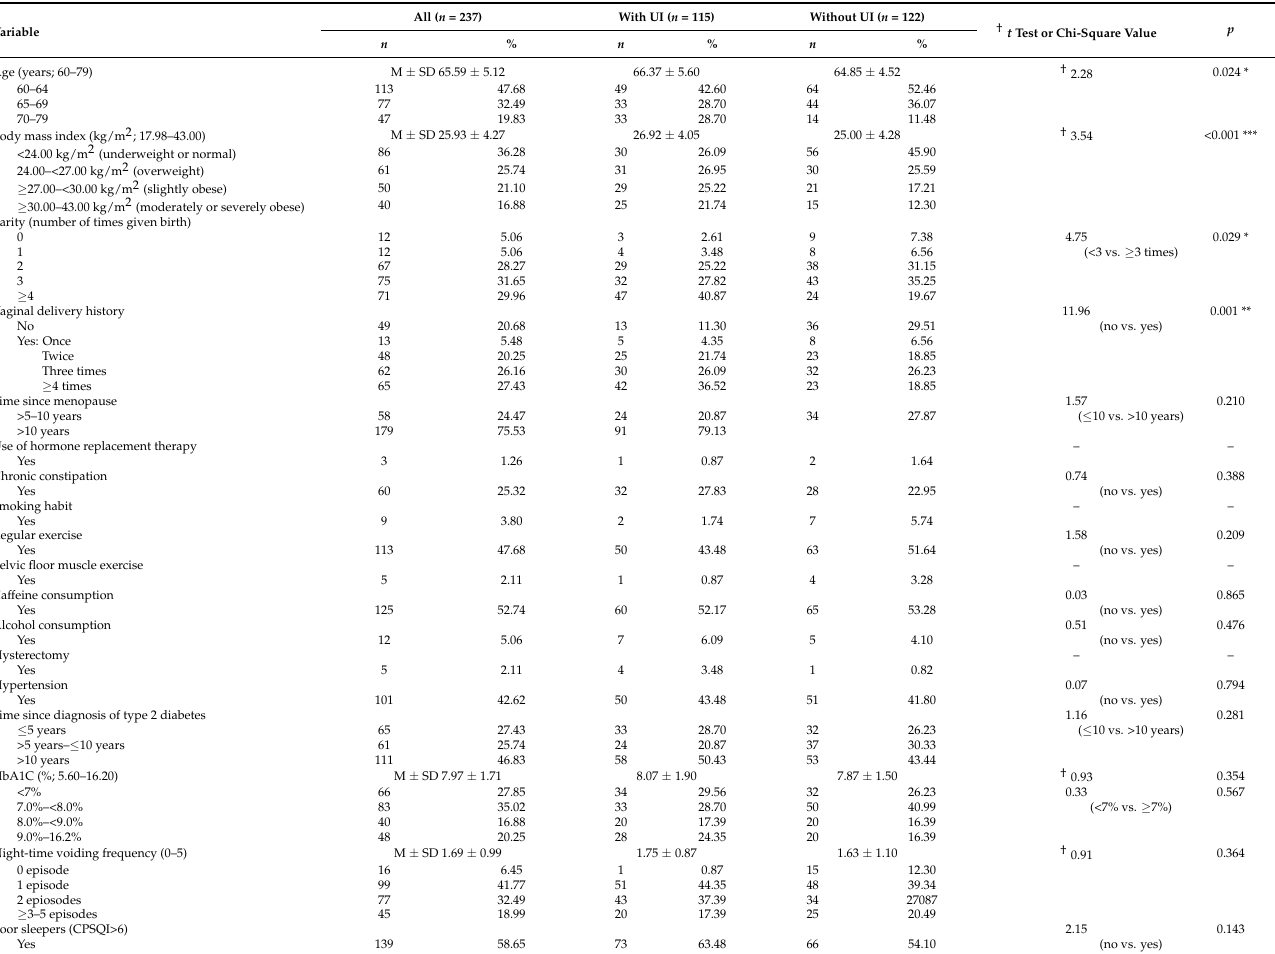
Table 1. Individual characteristics of study participants ( n =